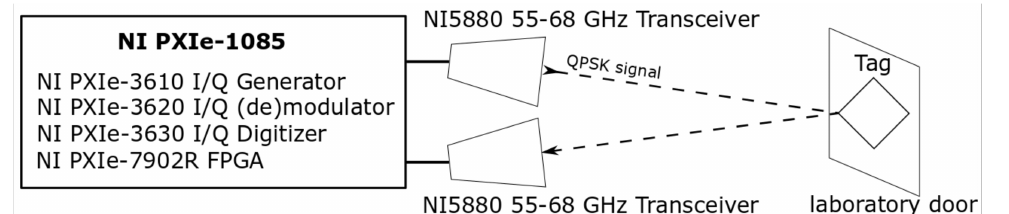
Figure 7. Schematic of the measurement setup in the indoor